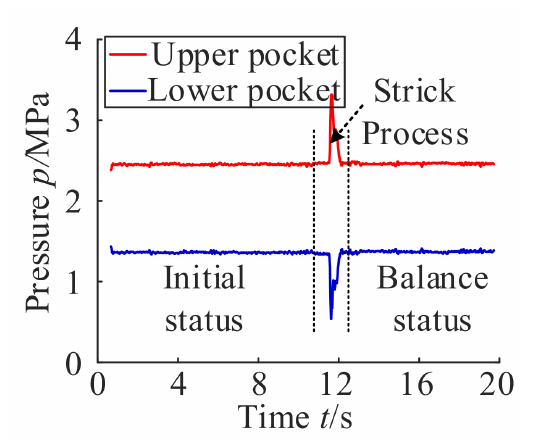
Figure 19. Oil pocket pressure by test when K p = −